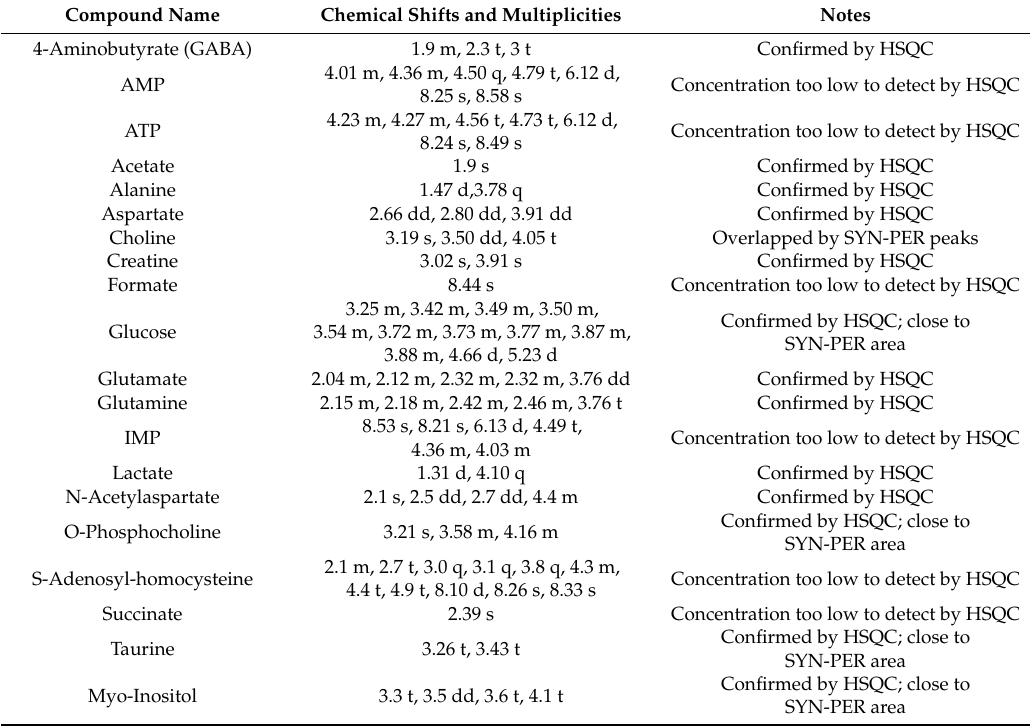
Table 1. Chemical shifts and multiplicities of 1 H NMR signals assigned to compounds in extracts of synaptosomes from control animals.